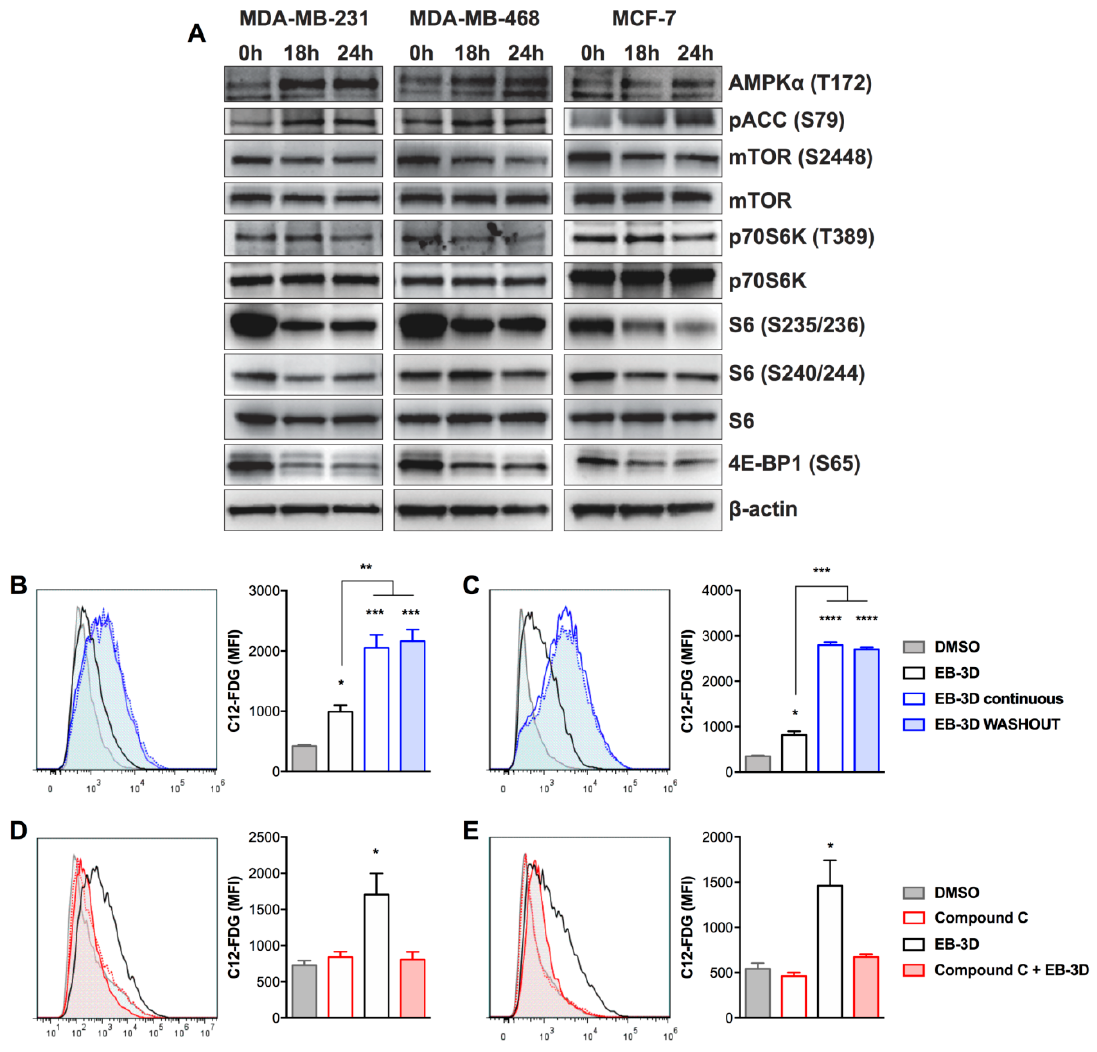
Figure 2. EB-3D affects AMPK-mTOR signaling pathway triggering cellular senescence. ( A ) Breast cancer cell lines were treated with 1 µ M of EB-3D or vehicle for the indicated time points. Cells were then lysed and probed with the indicated antibodies. Quantification and statistical analysis are depicted in Figure S4A–C. ( B – E ) Flow cytometry analysis of cellular senescence using C 12 -FDG probe. MDA-MB-231 ( B ) and MDA-MB-468 ( C ) were treated with 1 µ M of EB-3D for 72 h and then cells were supplied with fresh medium with (EB-3D continuous) or without (EB-3D WASHOUT) the ChoK α inhibitor for a further 72 h. MDA-MB-231 ( D ) and MDA-MB-468 ( E ) were treated with 1 µ M of EB-3D for 72 h or pretreated for 2 h with 2.5 µ M of Compound C . Data are represented as the C 12 -FDG mean fluorescence intensity (MFI) ± SEM of three independent experiments. Statistical significance was determined using ANOVA with Newman–Keuls correction. Asterisks indicate a significant difference between the treated and the control group, unless otherwise specified. * p < 0.05, ** p < 0.01, *** p < 0.001, **** p < 0.0001.